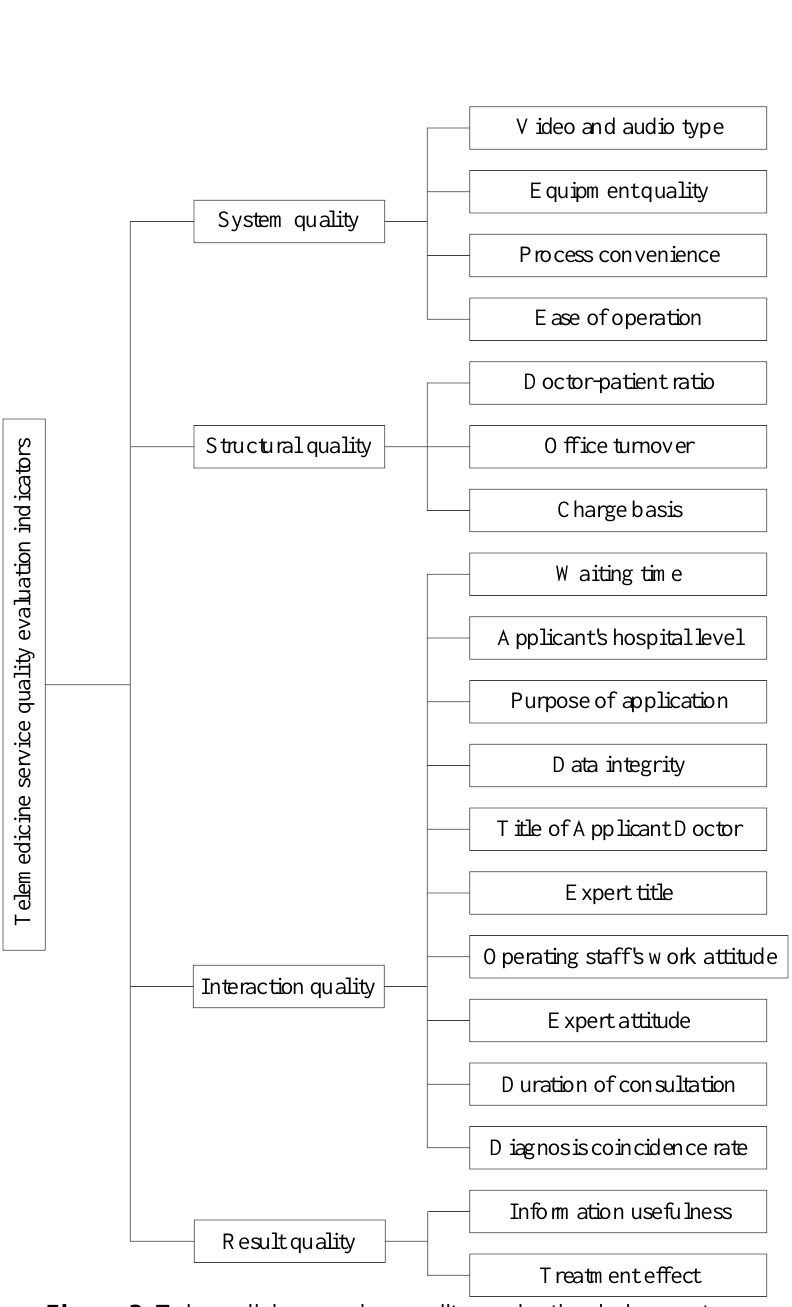
Figure 3 . Telemedicine service quality evaluation index